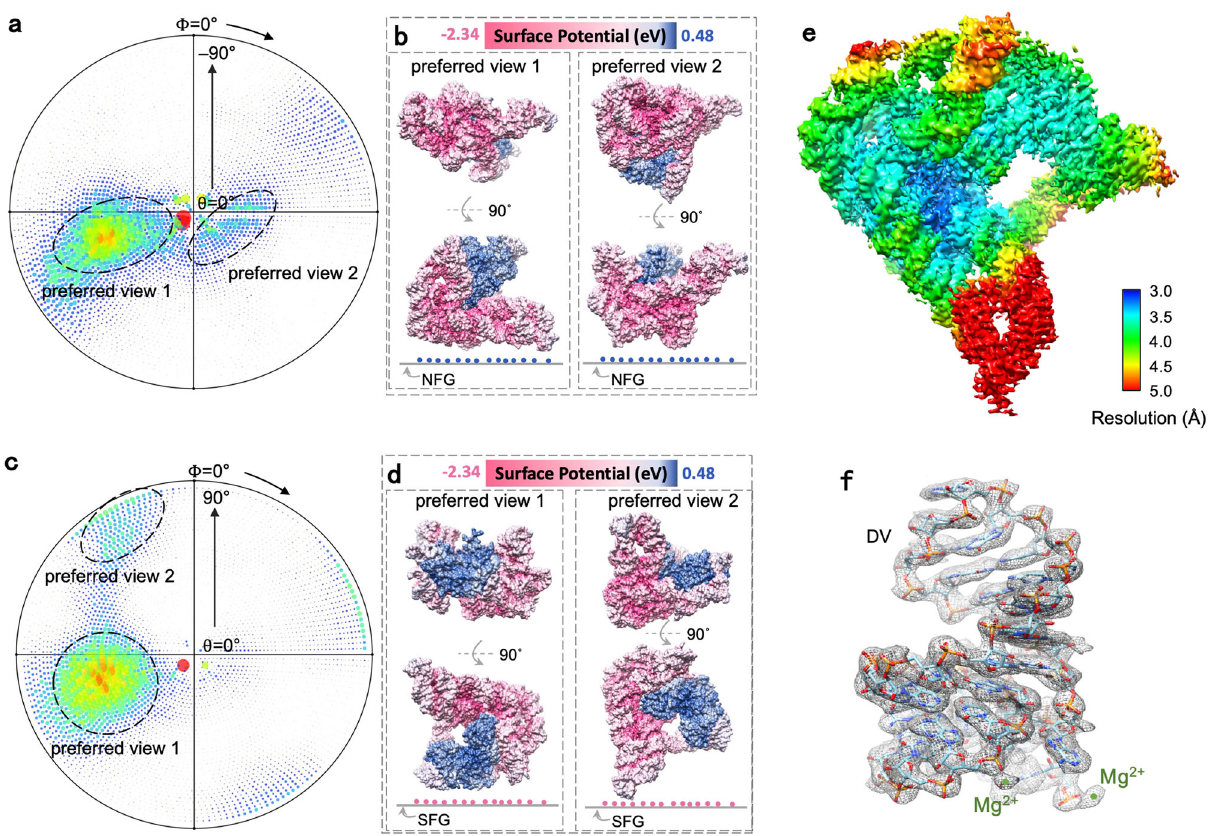
Fig. 4 | Graphene modi fi ed by distinct ligands for cryo-EM reconstruction of Ll.LtrB RNP. a – d The particle-orientation distribution of L1.LtrB RNP complex on NFG ( a , b ) and SFG ( c , d ). Note that the preferred view 1 in ( a ) is the opposite-side projection of the preferred view 1 in ( c ). e The reconstructed 3D density map of